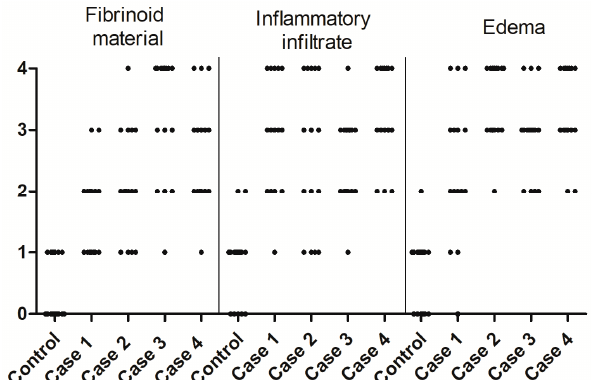
Figure 2. Quantification of the histopathological alterations. Fibrinoid material, inflammatory infil- infiltrate and edema were quantified in the placental tissue of the control and cases 1, 2, 3 and 4 using an arbitrary scale with the following degrees: 0—absent, 1—light and focal, 2—light, 3—moderate and 4—diffuse. and